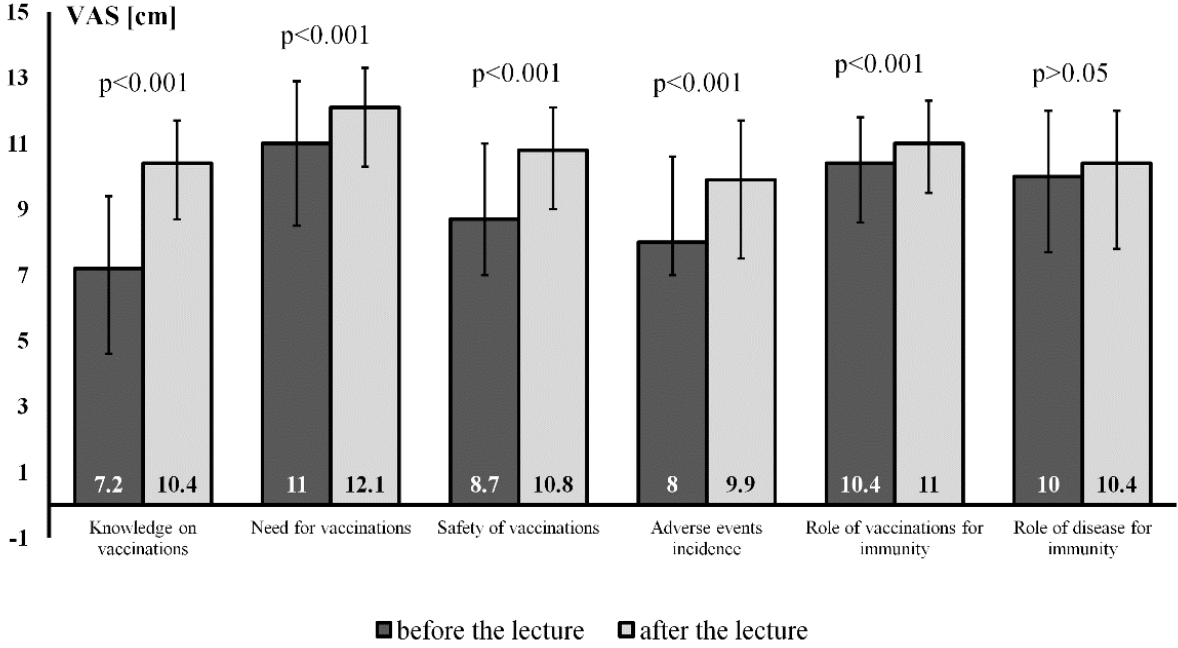
Figure 1. The attitudes towardsvaccinations (visual analogue scales 0–15 cm) before and after the lecture in female lecture participants (medians (boxes) and interquartile ranges (whiskers)). For details, see the Methods section and File S1.